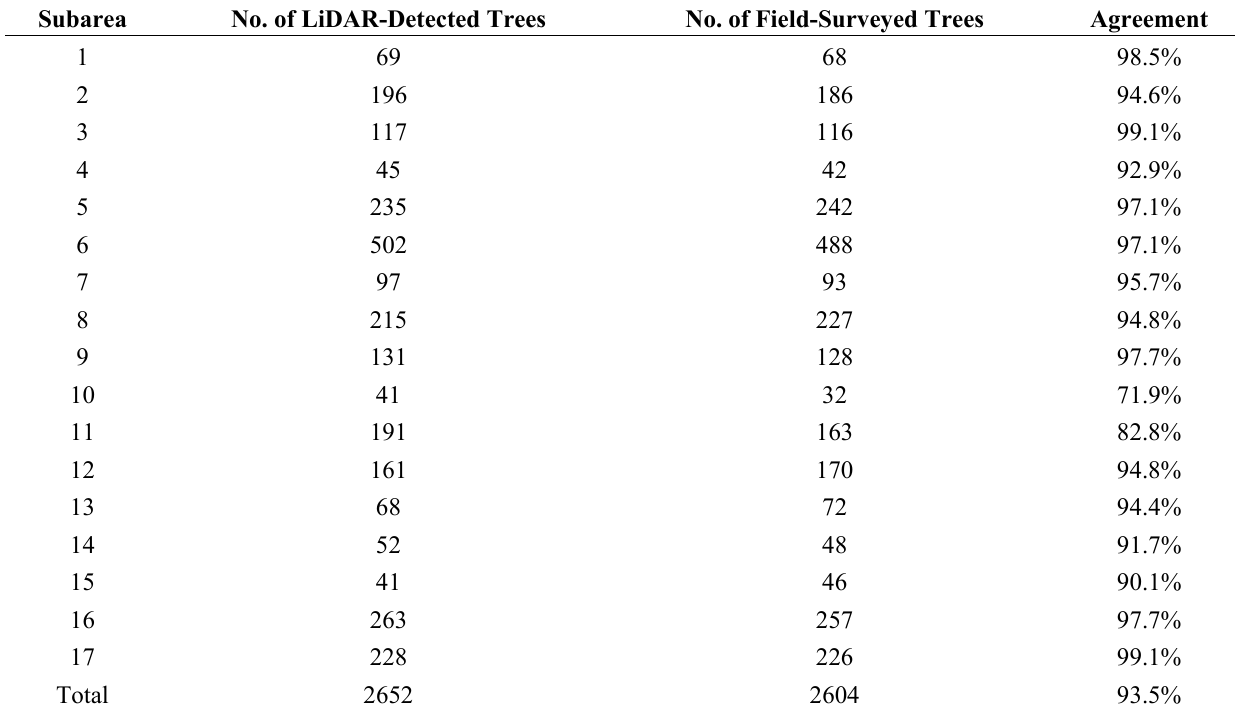
Table 1. The number of LiDAR-detected, field-surveyed trees, and agreement of LiDAR detection for 17 selected testing